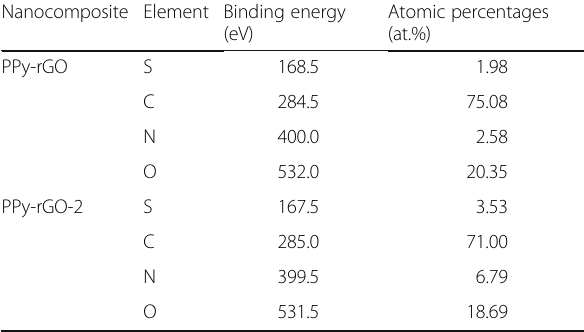
Table 1 Elemental compositions of fabricated nanocomposites Nanocomposite Element Binding energy Atomic percentages (eV)